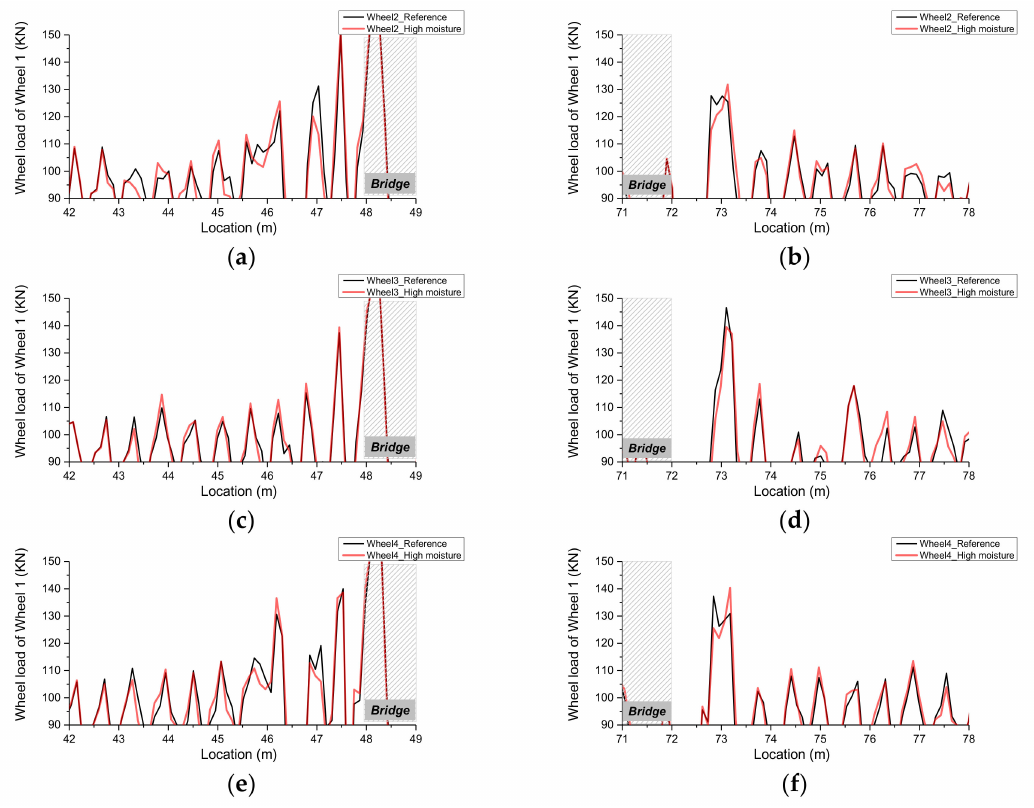
Figure 15. Dynamic wheel loads: ( a ) zoom-in of the embankment-bridge side of Wheel 2; ( b ) zoom-in of the bridge-embankment side of Wheel 2; ( c ) zoom-in of the embankment-bridge side of Wheel 3; ( d ) zoom-in of the bridge-embankment side of Wheel 3; ( e ) zoom-in of the embankment-bridge side of Wheel 4; and, ( f ) zoom-in of the bridge-embankment side of Wheel 4 (unit: